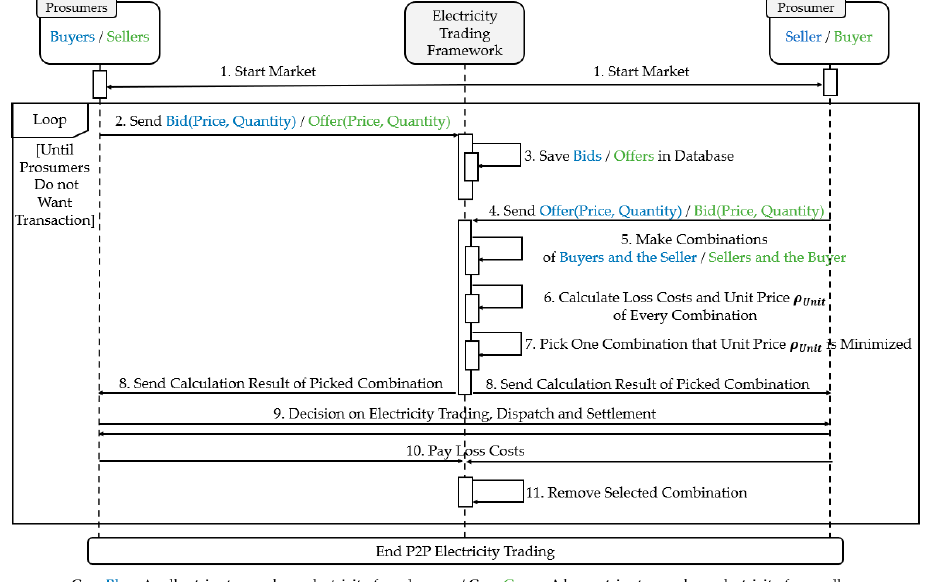
Figure 1. Sequence diagram of the loss-guided P2P trading.